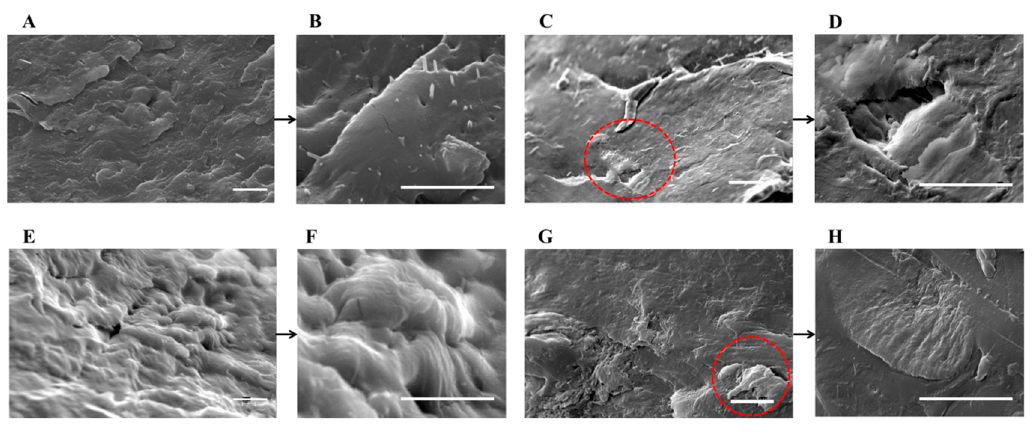
Figure 2. SEM images of ( A , B ) PA6 in situ _HNT H _4; ( C , D ) PA6 in situ _HNT S _4; ( E , F ) PA6 in situ _HNT H _4_APTES; and ( G , H ) PA6 in situ _HNT S _4_APTES (scale bar 2 µm).